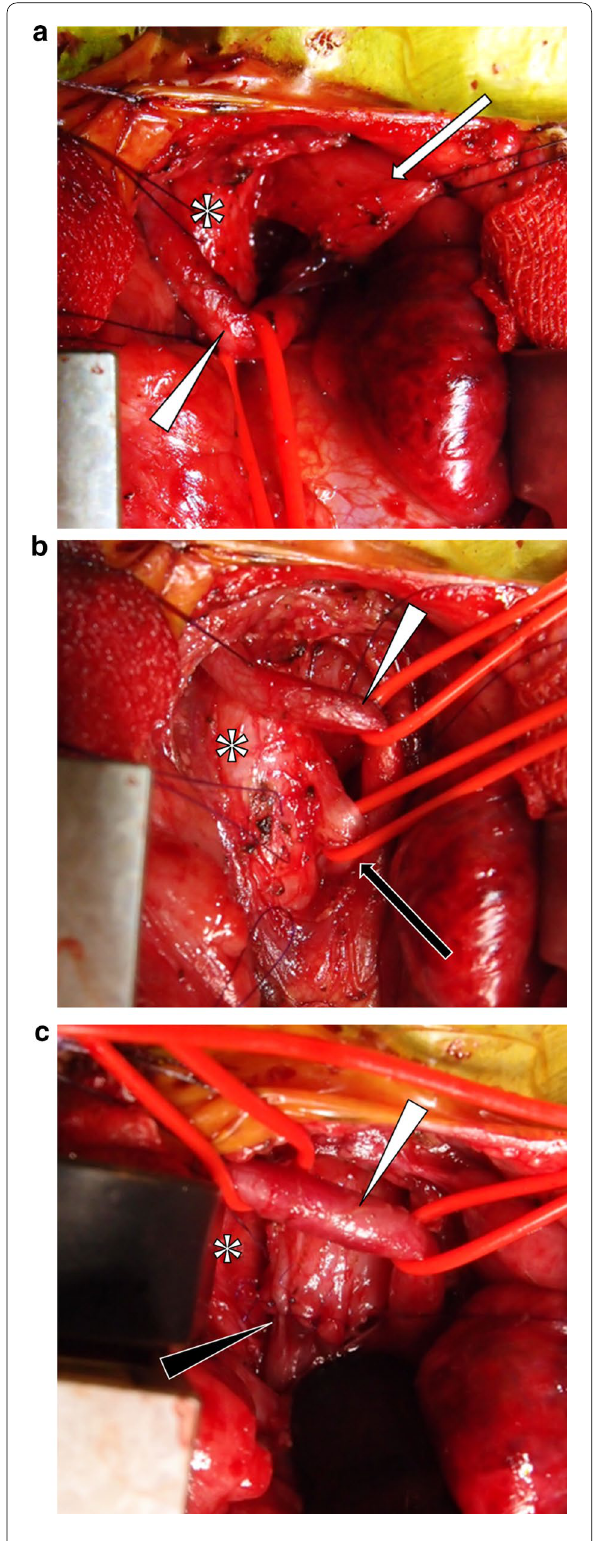
Fig. 2 a – c Photographs of the surgical field. The upper pouch of the esophagus (white arrow), the trachea (white asterisk), the brachiocephalic artery (white arrowhead), the TEF (black arrow), and anastomosis of the esophagus (black